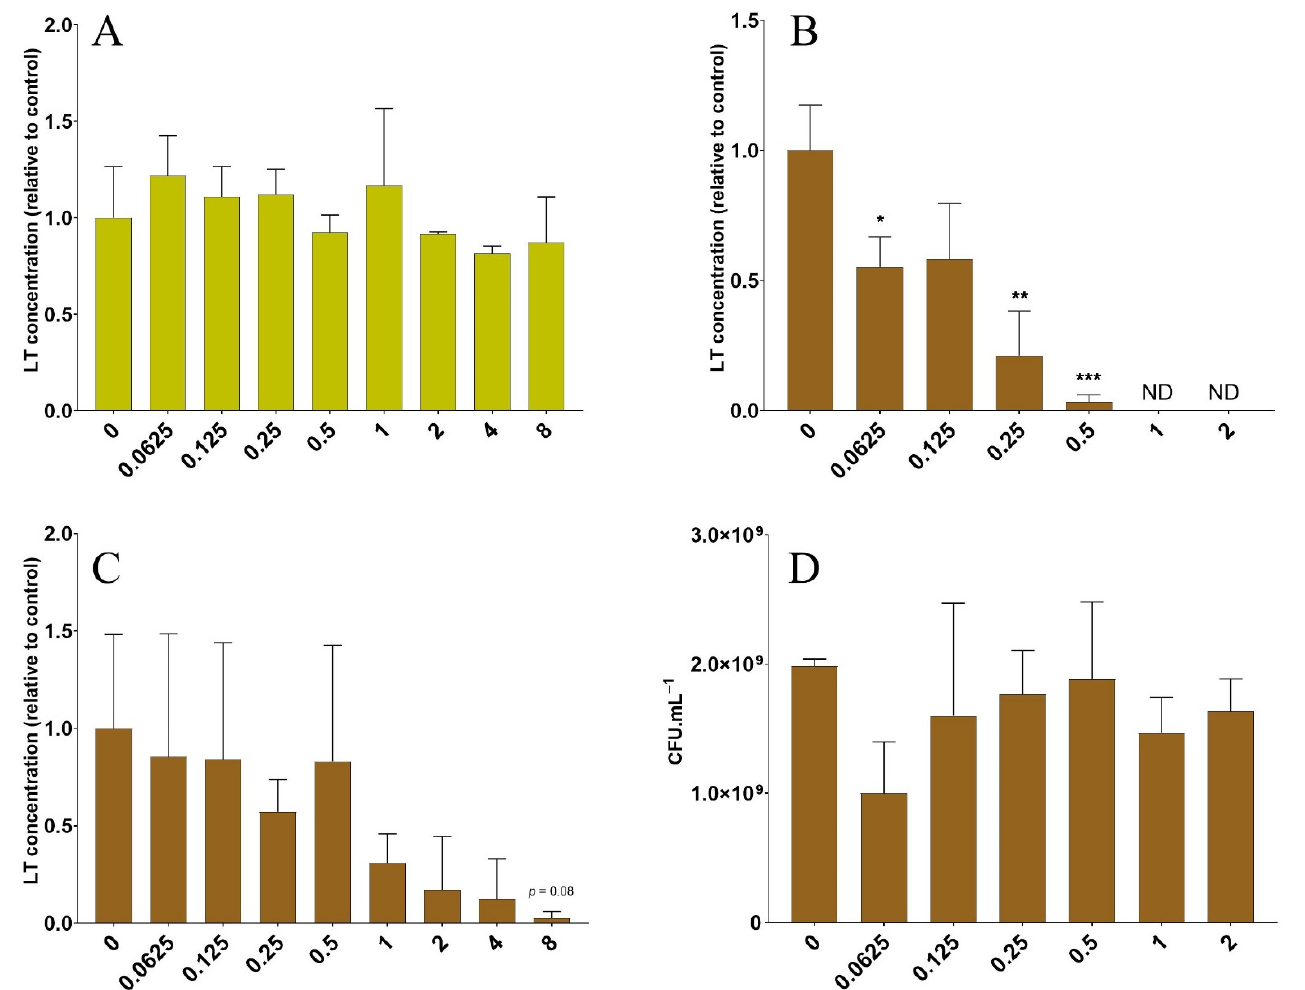
Figure 2. Dose effect of fiber-containing products on LT toxin concentrations in broth media. LT concentrations were measured in CAYE medium after overnight incubation with ETEC strain H10407 ( A , B ) or pure LT-Cholera B toxin sub-unit ( C ) and increasing doses of specific yeast cell walls ( A ) or lentil extract ( B , C ). Fiber-containing product concentrations are expressed in g · L − 1 of final fiber content. Results are expressed as mean variations ( ± SD) compared to the control condition (no product added). The data represent the replicates of three independent experiments. ( D ) The dose effect of the lentil extract on ETEC growth in CAYE medium after overnight incubation. Results are expressed as mean CFU · mL − 1 ( ± SD) of three independent replicates. Statistical differences with the non-treated control condition were provided by Tukey’s multiple comparisons tests (*: p < 0.05; **: p < 0.01; ***: p < 0.001). ND = non-detected .